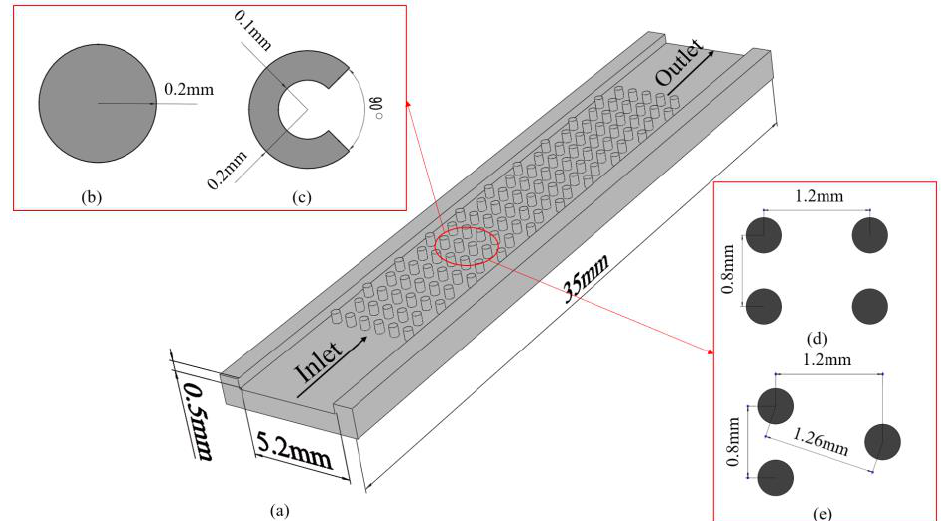
Figure 1. Sketch of the micro-pin-fin array ( a ) microchannel with pin-fins, ( b ) the circular micro-pin- fin, ( c ) the 3/4 ring-shaped micro-pin-fin, ( d ) in-line arrangement and ( e ) staggered arrangement. The dynamic viscosity of water varies with temperature and is determined